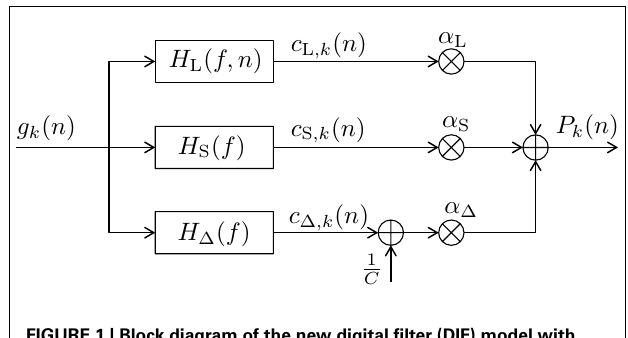
FIGURE 1 | Block diagram of the new digital filter (DIF) model with input g k ( n ) in (10) and output P k ( n ) in (9), digital filter transfer functions H ( f ) with 0 ≤ f ≤ f s /2, a stimulus presentation rate of f s ( = 2/3Hz), and probability normalizing constant 1/ C